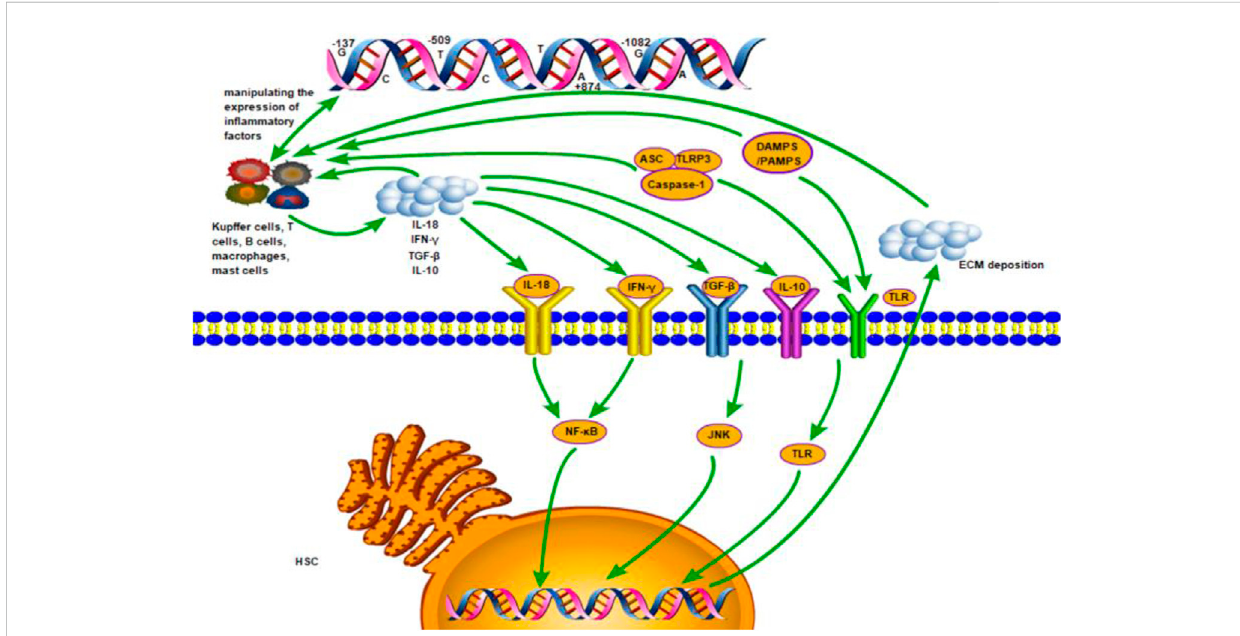
FIGURE 4 The in fl ammation mechanism of liver fi brosis mediated by in fl ammatory factors. Various immune cells (i.e., T cells B cells, macrophages mast cells and speci fi cally Kupffer cells) are recruited in the liver tissue. These immune cells further release more in fl ammatory cytokines (i.e., IL-10, IL-18, TGF- β 1 and IFN- γ ), which, together with damage-associated molecular pattern (DAMPS), pathogen-associated molecular patterns (PAMPS) or in fl ammasomes releasedbyinjuredordeadlivercells,inducemoresecretionofin fl ammatoryfactorsandstimulateHSCbyactivatingthenuclearfactorkappaB(NF- kB) pathway, the c-Jun N terminal kinase (JNK) pathway and the Toll-like receptor (TLR) signaling pathway. The active HSC secrete much extracellular matrix (ECM) and cause deposition, so that chronic liver in fl ammation persists and leads to the formation of liver fi brosis. These processes are controlled by related